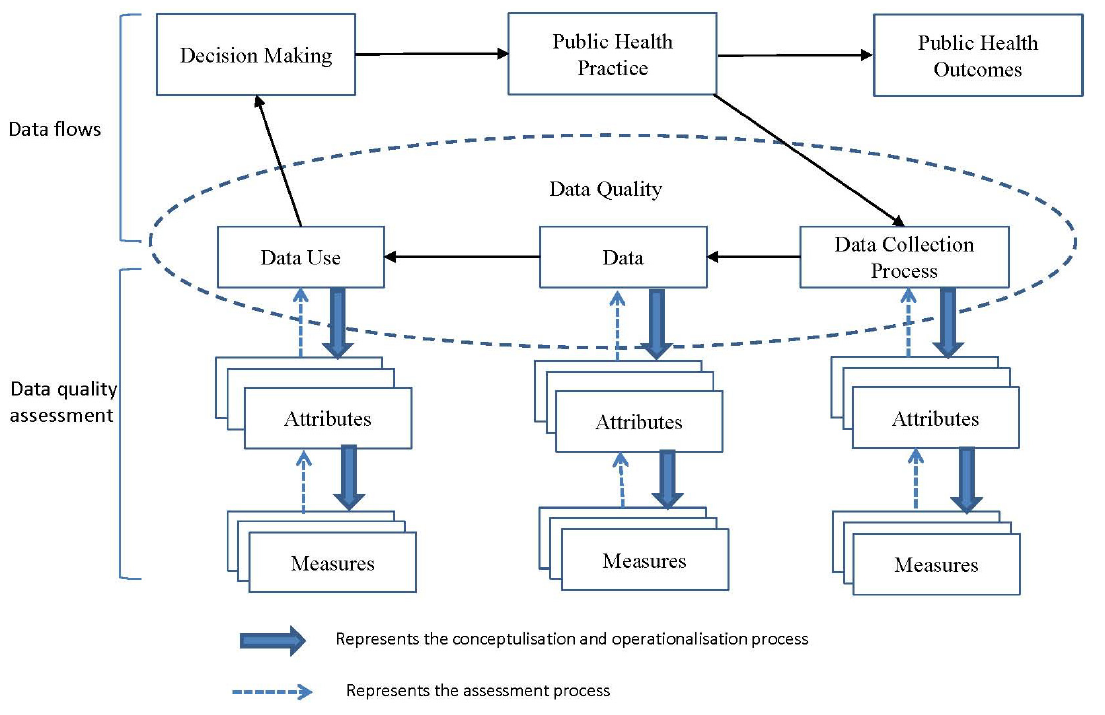
Figure 1. Conceptual framework of data quality assessment in public health